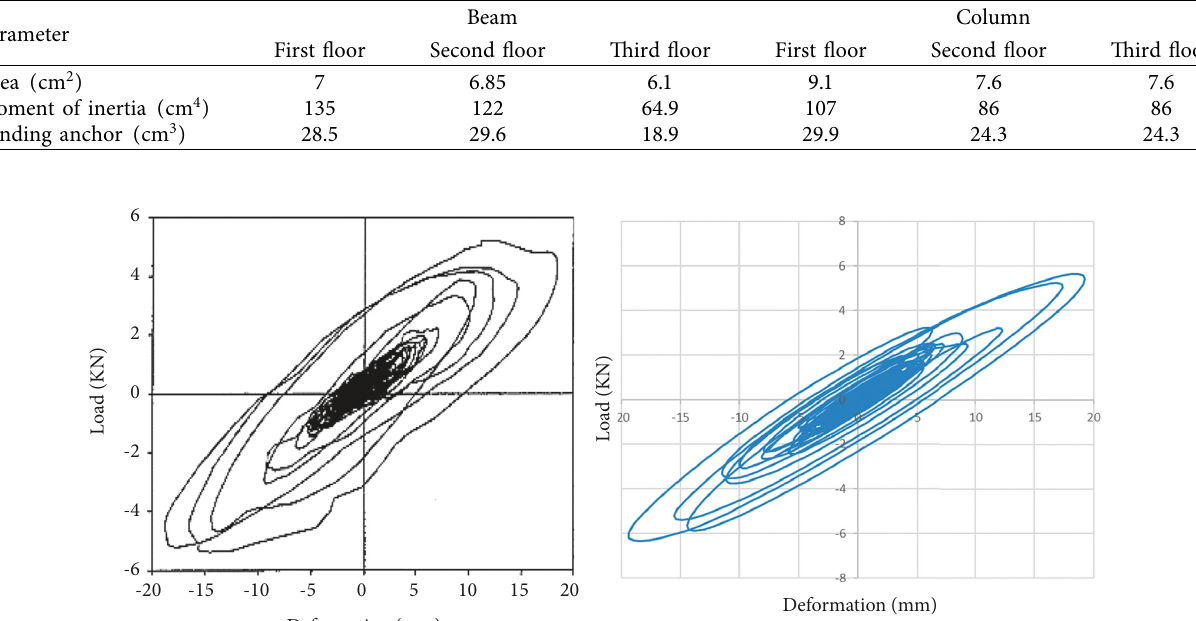
Figure 5: Curve of viscoelastic damping hysteresis under centrifugal earthquake, this figure is reproduced from reference [47], in comparison with extracted results from Perform3D.